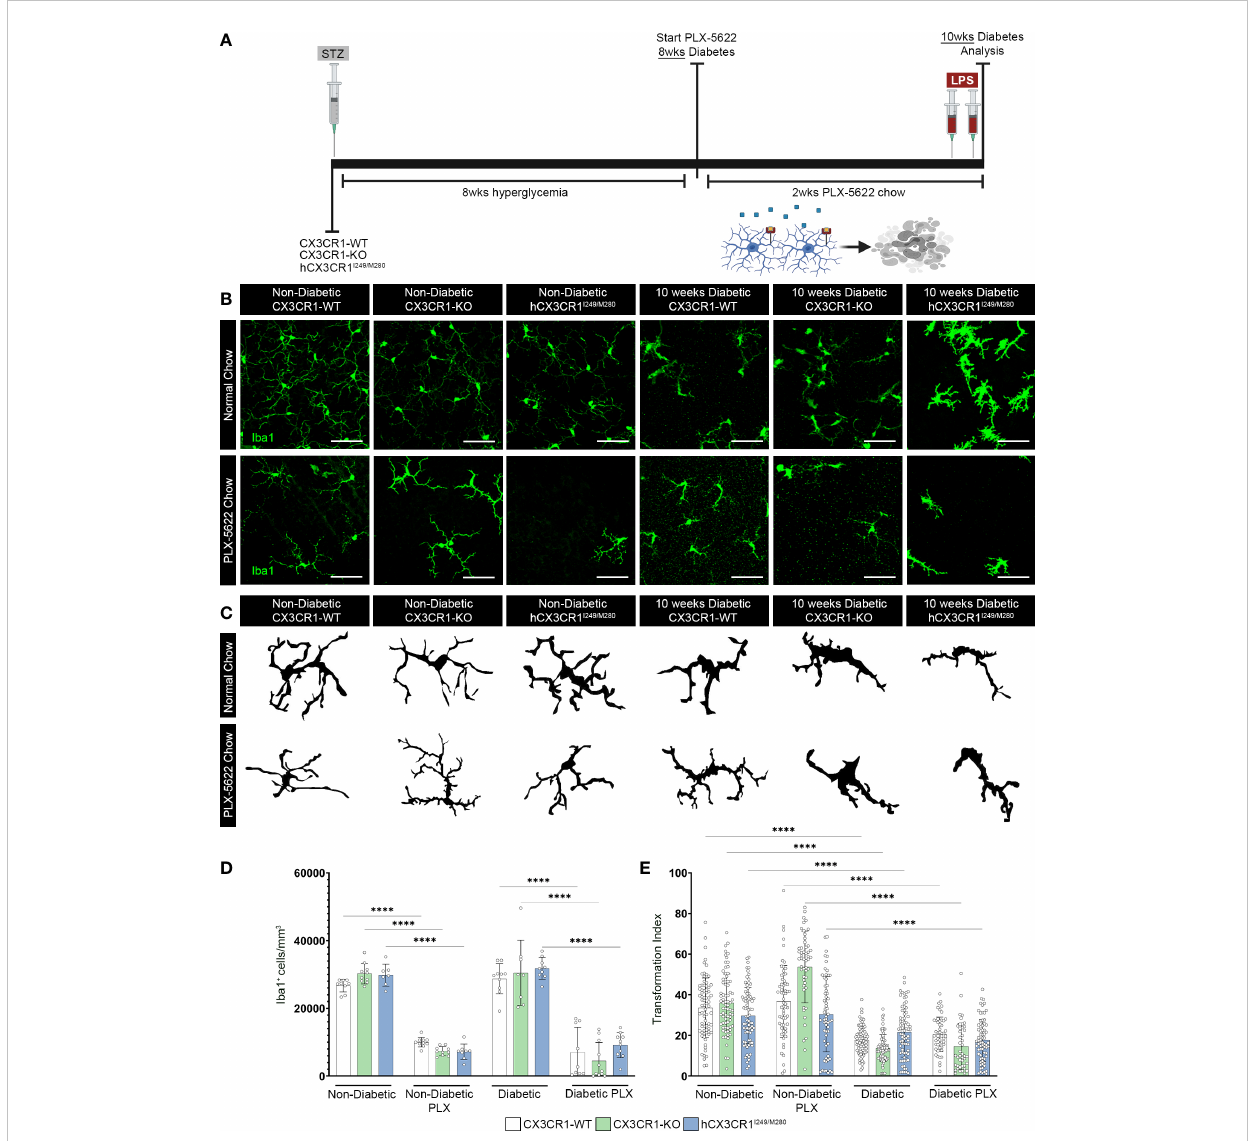
FIGURE 3 CSF-1R antagonism induces robust microglia depletion in the diabetic retina. (A) Microglia were pharmacologically depleted using PLX-5622 in non- diabetic and 8-wks diabetic CX3CR1 -WT, CX3CR1 -KO, and hCX3CR1 I249/M280 mice for two weeks. Non-diabetic control mice received citrate buffer. Non-depleted, non-diabetic and diabetic controls remained on normal chow. Confocal images of retinal tissues stained for Iba1 (green) (B) and transformation index cellular tracings (C) in CX3CR1 -WT, CX3CR1 -KO and hCX3CR1 I249/M280 mice. Confocal images represent the retinal ganglion cell layer in the peripheral retina. (D, E) , Quanti fi cation of retinal IHC analysis for Iba1 + cells/mm 3 (D) and transformation index (E) . Data show the average of the 2 central, 2 medial and 2 peripheral images taken per mouse. Data show mean ± SD, n = 6 to 10 mice per group where each dot represents an individual mouse (D) . Transformation index data show mean ± SD n = 44 to 75 microglia per group for n =5 mice where each dot represents an individual microglia cell (E) . **** P <0.0001 using 2-way ANOVA. Scale bars measure